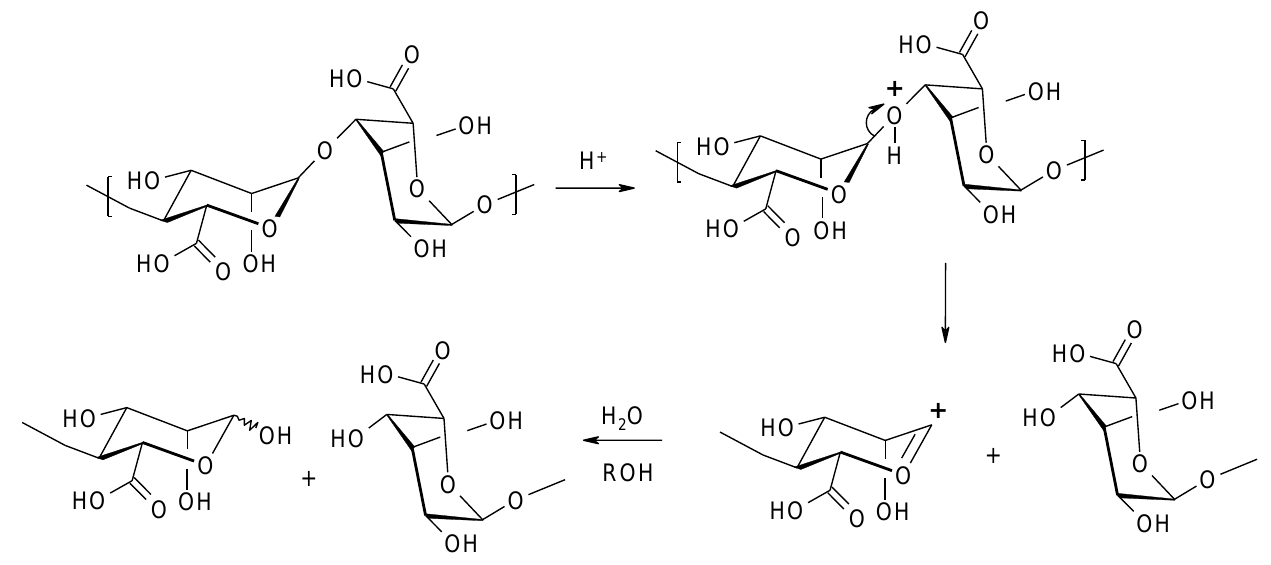
Figure 4. Acid-catalyzed degradation of alginic acid.